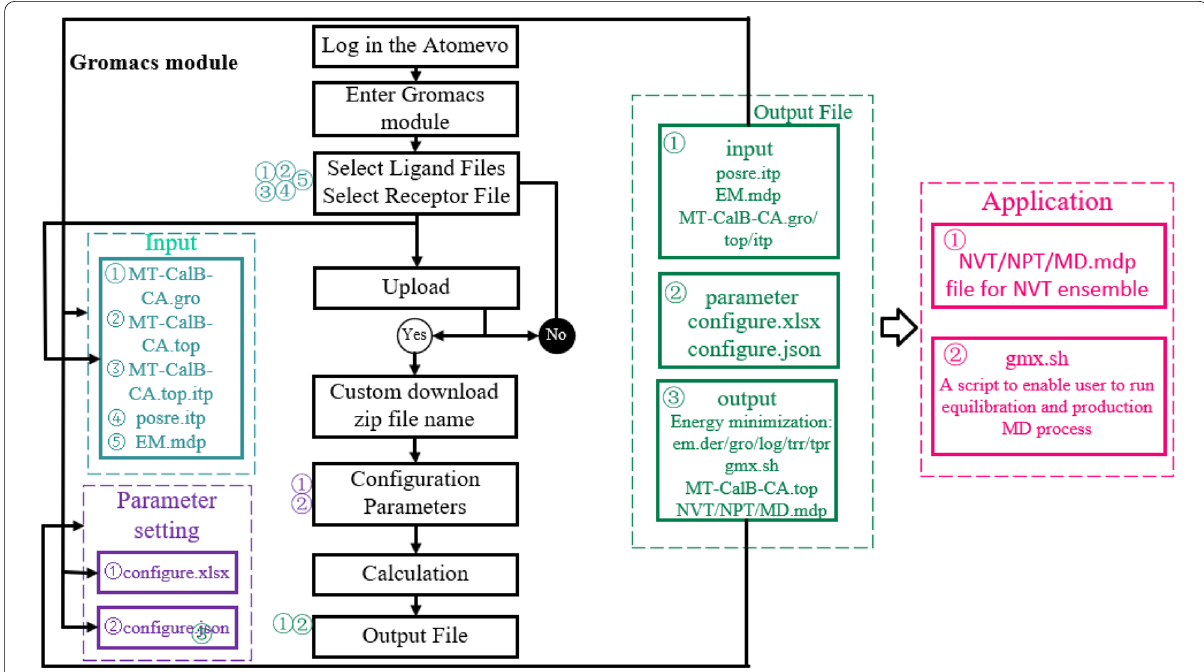
Fig. 3 Flow diagram of Gromacs model builder